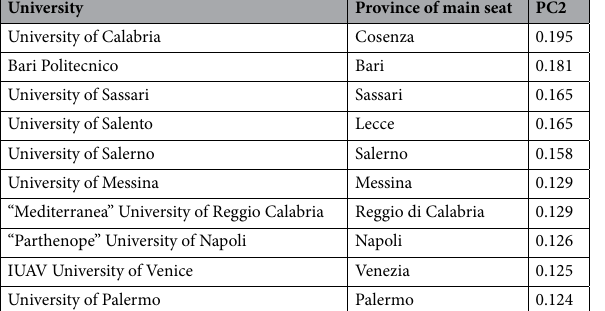
Table 6. Top ten universities in the ranking of the principal component PC2 associated to the CENSIS overall